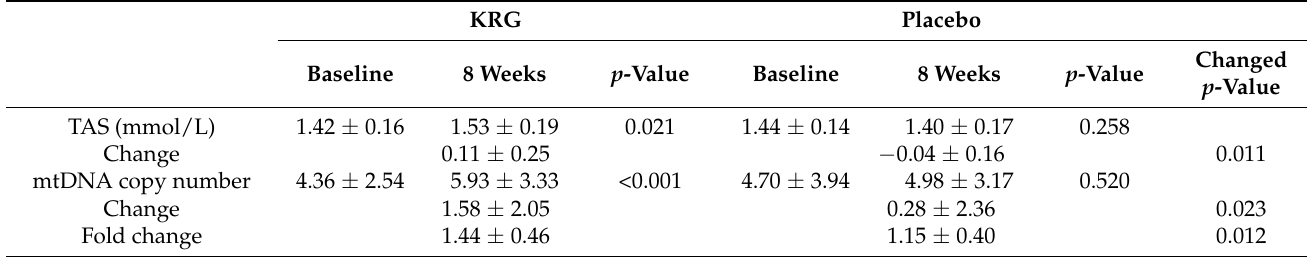
Table 3. Changes in antioxidant capacity and biological aging parameter of the KRG and placebo groups before and after 8 weeks.